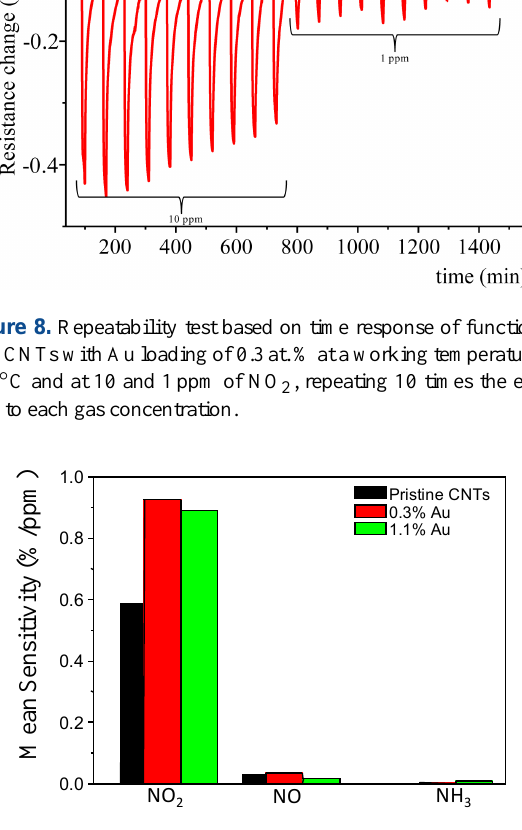
Figure 9. Mean sensitivity of CNT-based sensors towards NO 2 , NO and NH 3 gases at a sensor temperature of 150 °C.